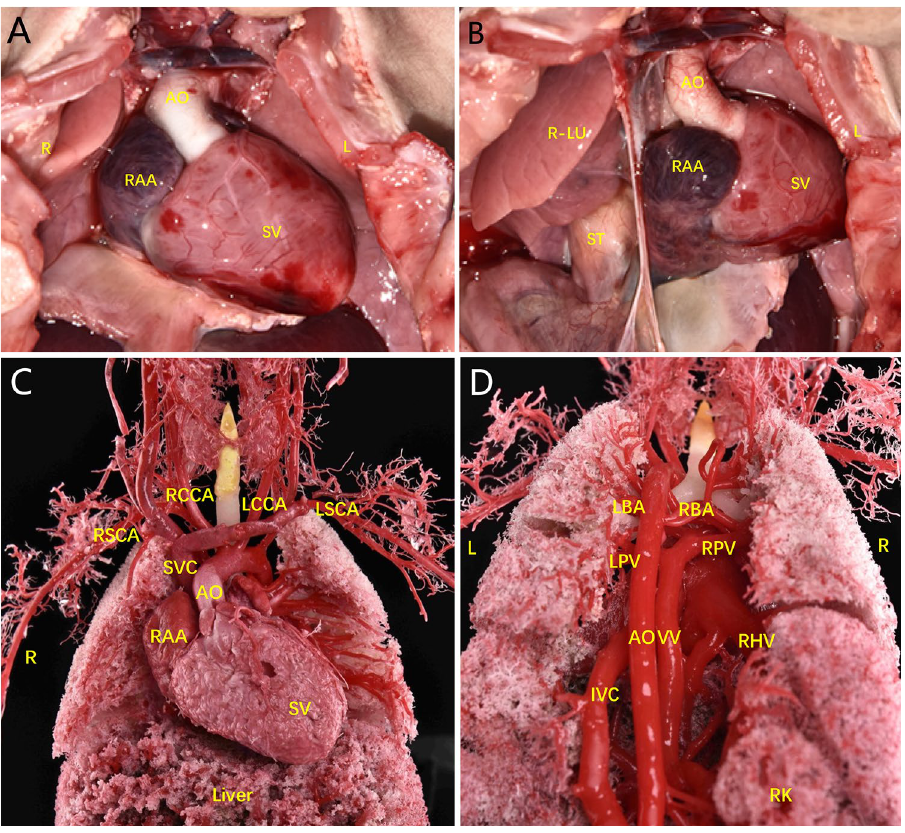
Figure 11. Postnatal anatomic and cardiovascular cast findings. ( A , B ) The prenatal examination revealed a single ventricle, pulmonary atresia, left and right collateral arteries from the descending aorta supplying both lungs, left and right PVs converging to form a PV trunk and descending into the portal vein via the vertical vein.